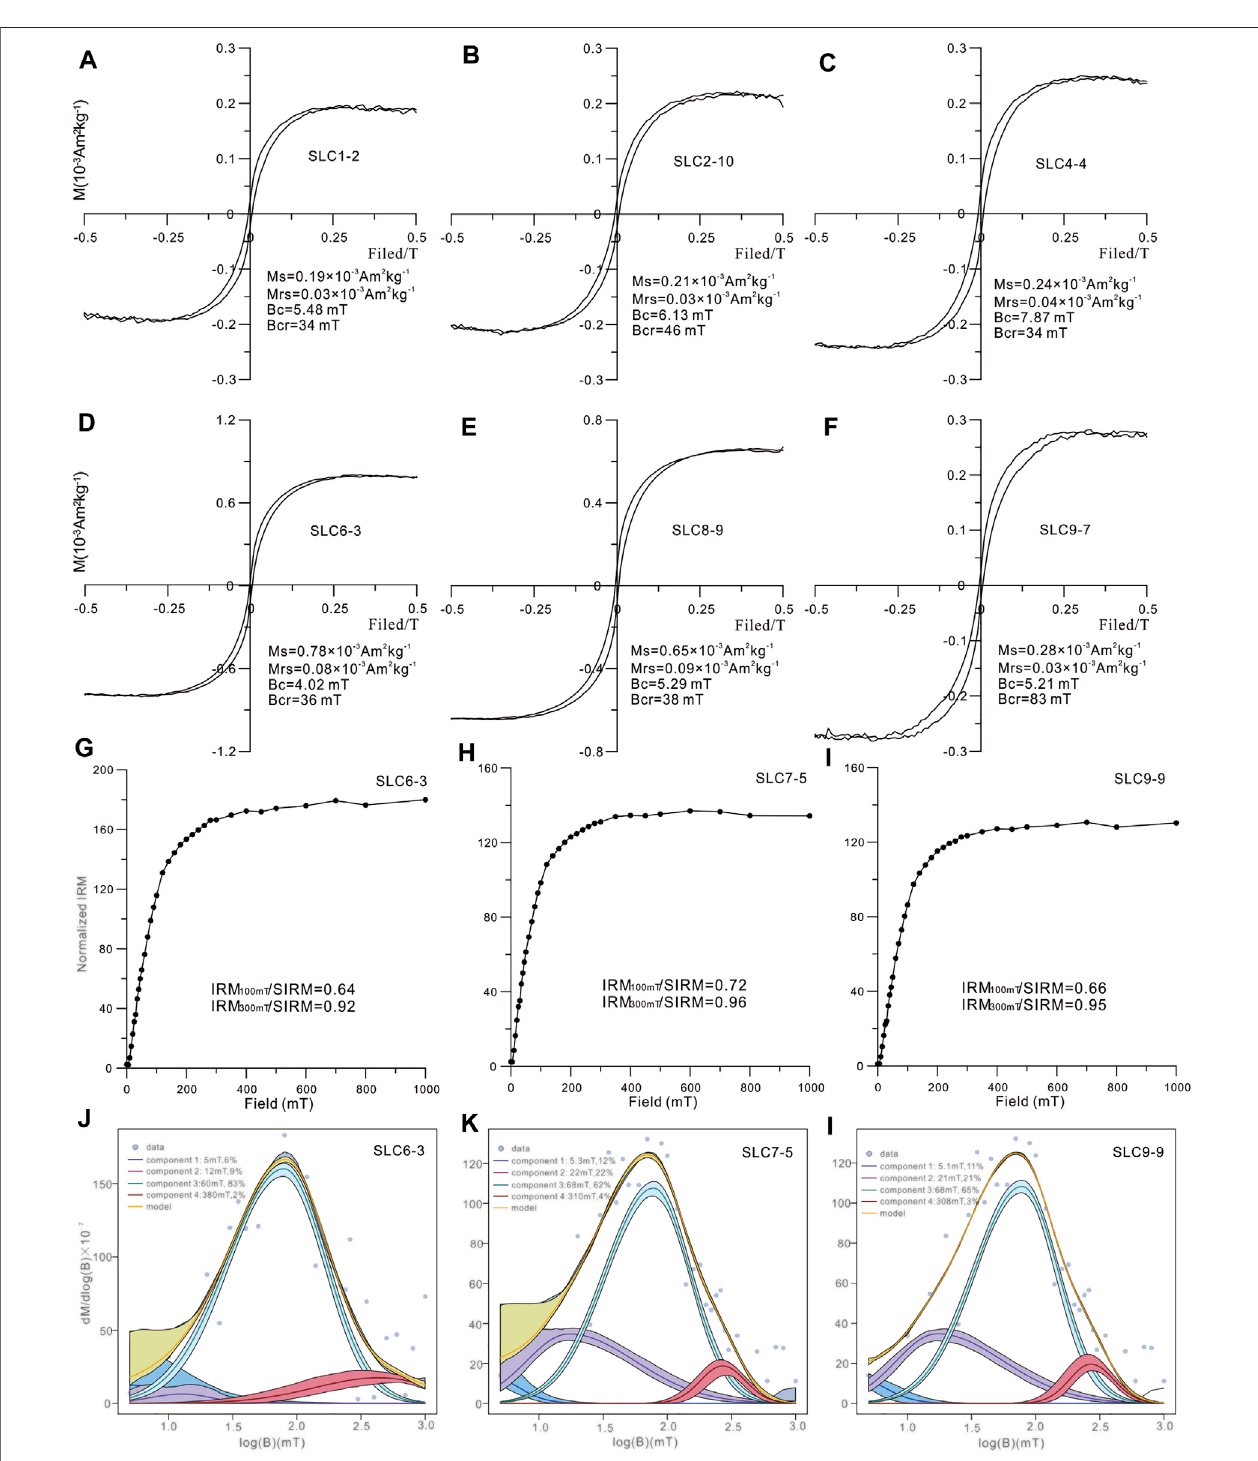
FIGURE 6 | Hysteresis loop, IRM curves, and IRM component analyses for the representative samples (A – F) Hysteresis loops (G – I) IRM curves (J – L) IRM component analysis. Abbreviations: M s , saturation magnetization; M rs , saturation remanence; B c , coercivity; and B cr , remanent coercivity.